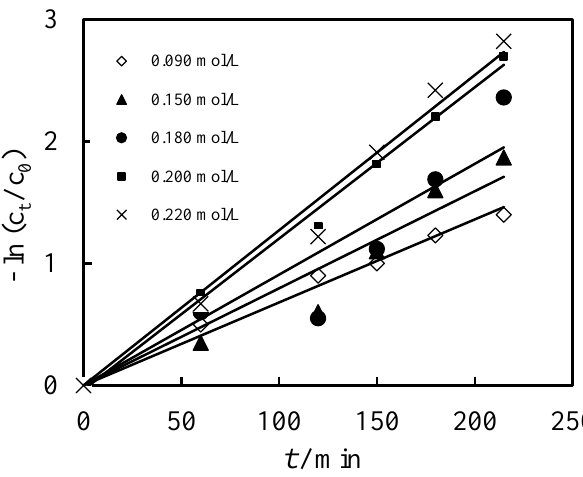
Figure 5. Effects of N235/7301 concentration on the dislodging efficiency of Cr (VI).